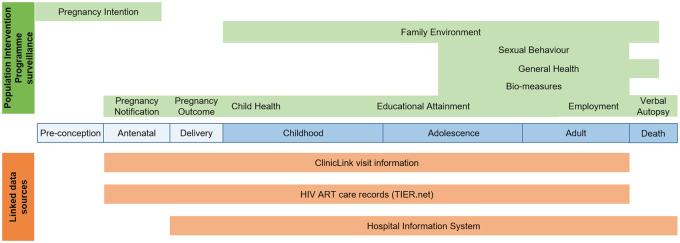
Data gathered in PIP surveillance (green) and linked data sources, demonstrating the potential to address a range of health research questions across all the stages of the life course